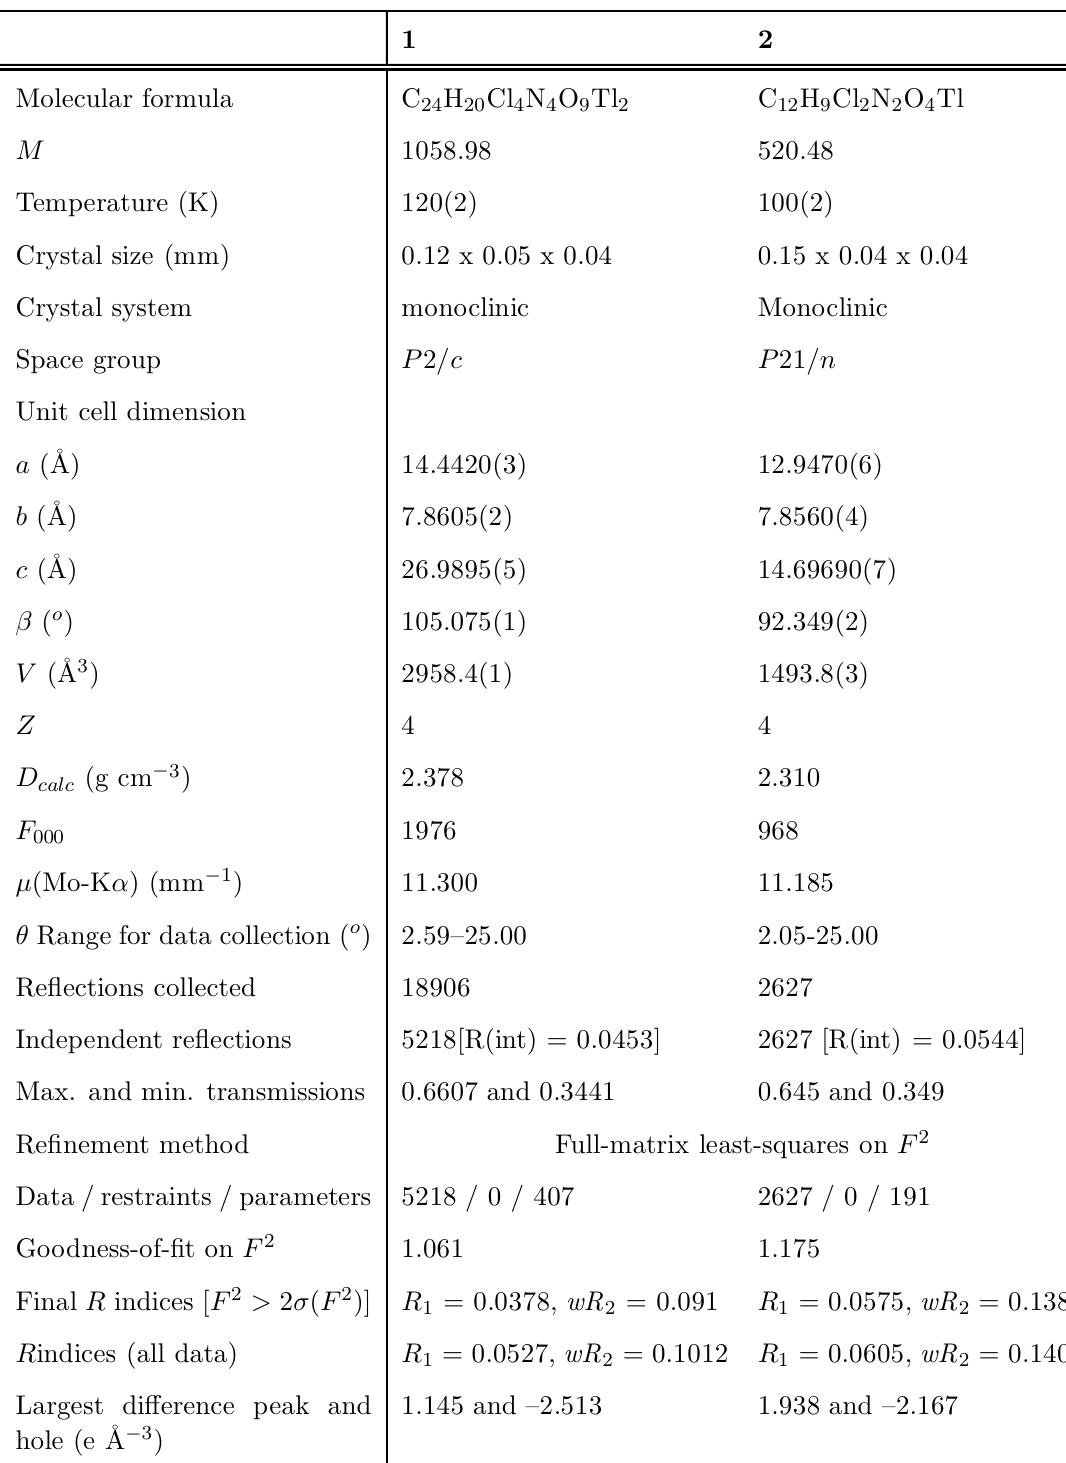
Table 2 Crystal data and details of structure re› nement for [TlCl 2 (pic)(Hpic)] ¢ 0.5H 2 O ( 1 ) and [TlCl 2 (nic)(Hnic)] ( 2